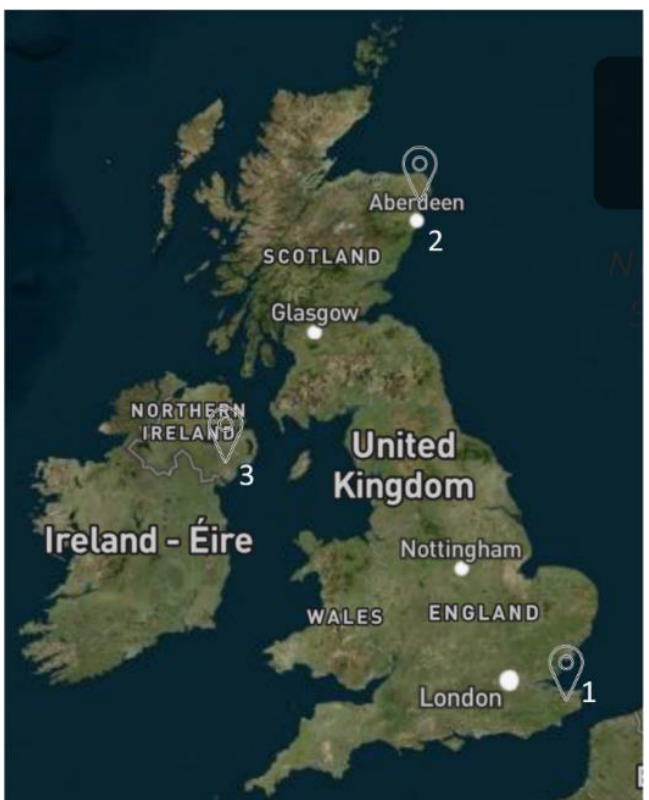
Figure 1. Map of case study locations: Domaine Evremond (1), Trump International Golf Links (2), and AgriAD (3) (Author’s own, sourced from Open Street Map, 2021).